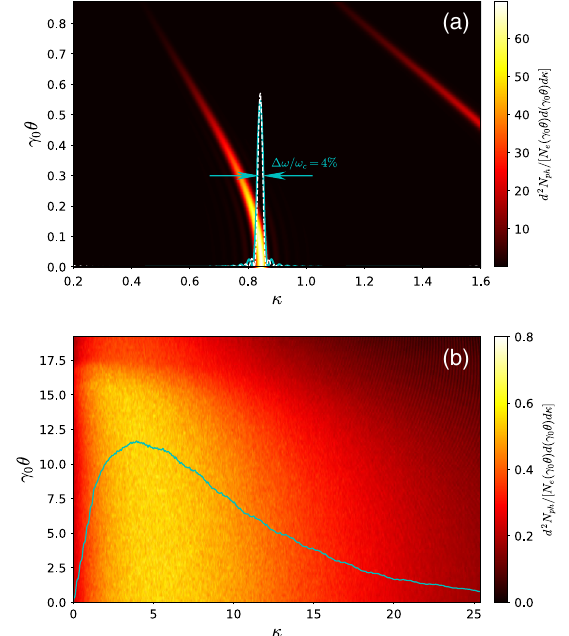
FIG. 6. Radiation spectrum from plasma-based undulator/wig- ≃ 0 . 62 and (b) a ≃ 16 . Dashed white line is the gler with (a) a u u theoretical on-axis solution and solid cyan lines in both plots are for the numerical on-axis radiation with γ 0 θ ¼ 0